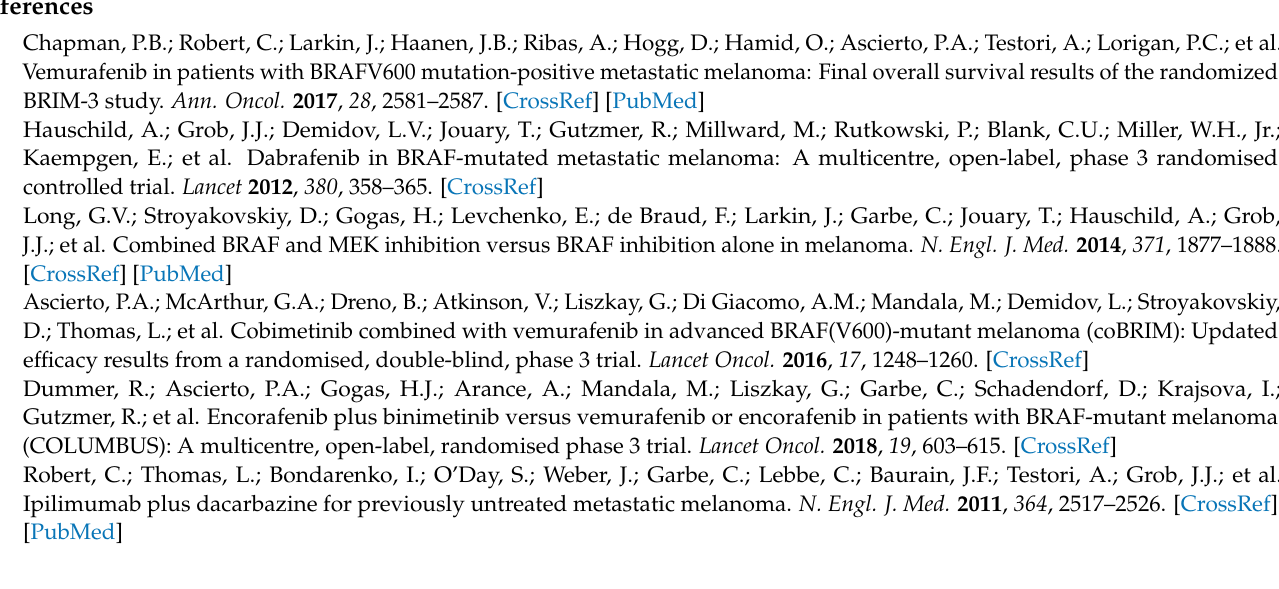
Table S17: Total DGE list correlated with PFS to TT, Table S18: Total DGE list correlated with specific tumor response to ICI, Table S19: Total DGE list correlated with overall clinical response to ICI, Table Table S21: Clinical characteristics in IHC validation